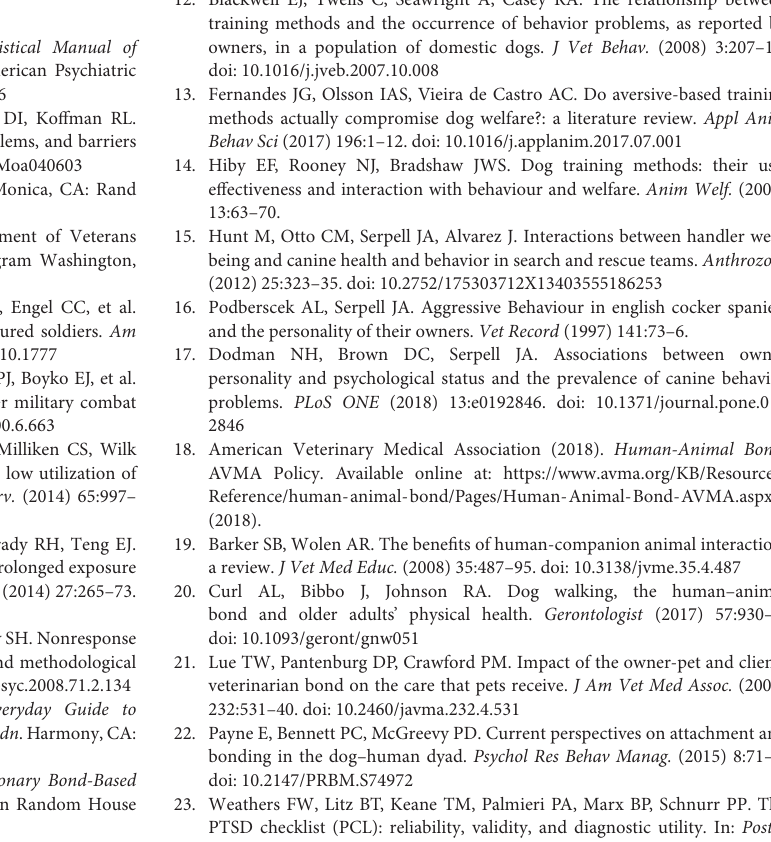
Supplemental Table 1 | Questionnaire for military veterans. The question scale, question text, response options, and coded response values of the survey given to military veterans about their PTSD service